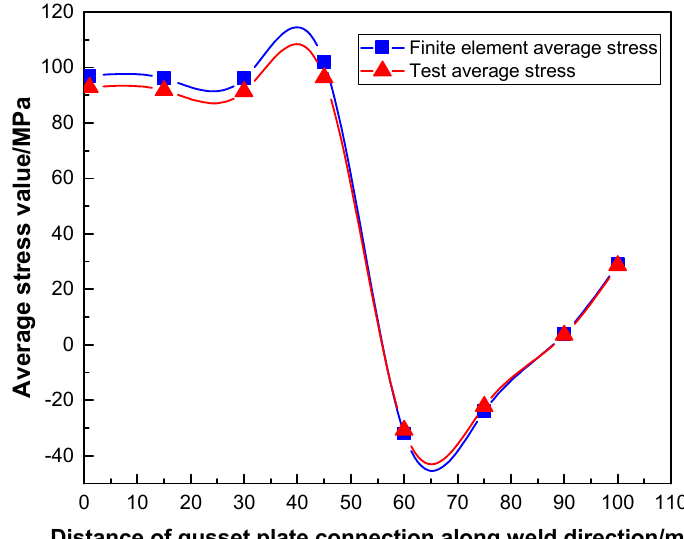
Figure 18. Analysis of finite element and experimental values of PDLDPJ.